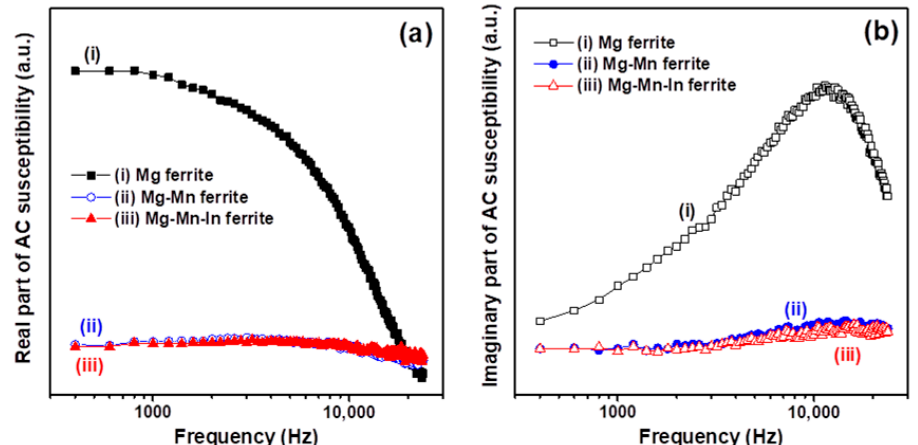
Figure 5. Frequency-dependent alternating-current (AC) magnetic susceptibility ( χ ) spectra of Mg, Mg-Mn, and Mg-Mn-In nanaferrites: ( a ) real part ( χ′ ) and ( b ) imaginary part ( χ″ ).